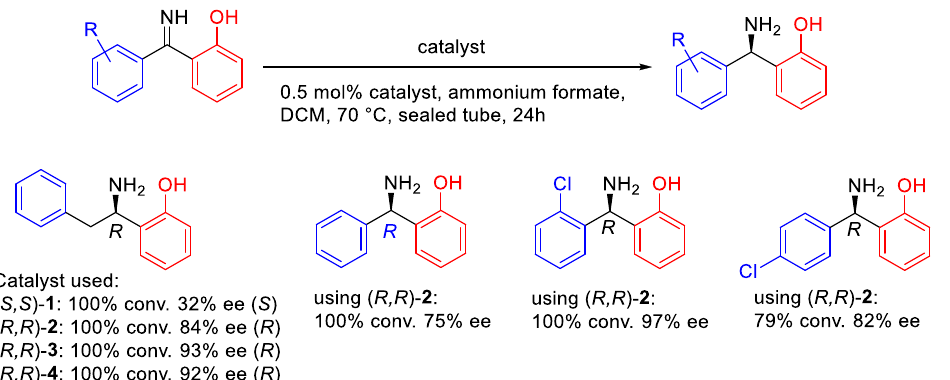
Figure 14. ATH of imines using a tethered catalyst.